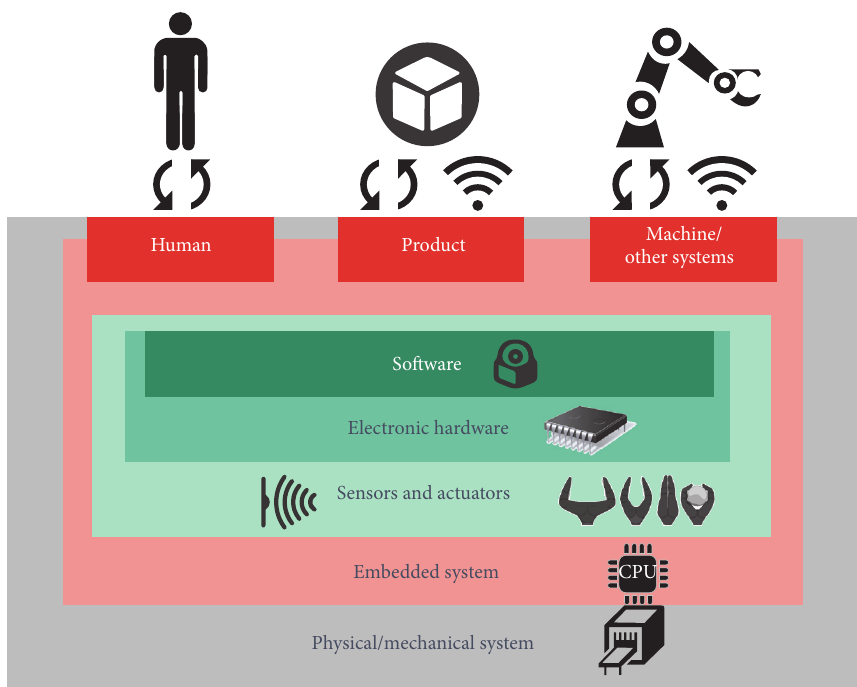
Figure 1: Layers of cyberphysical systems and interactions with their environment (adapted from